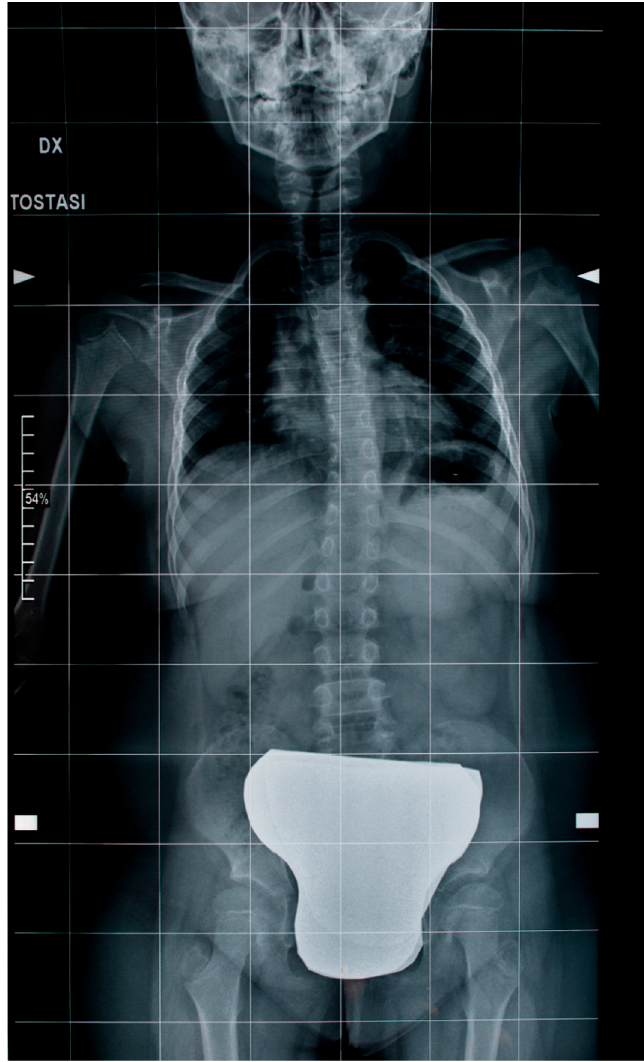
Figure 6. Standard X-rays of the spine revealed a scoliotic attitude of the dorsal–lumbar spine. The genetic investigation confirmed the presence of a homozygous ROBO3 variant (c.3584_3588dup, p.Ile1197TrpfsTer44), which causes a shift in the reading window and a